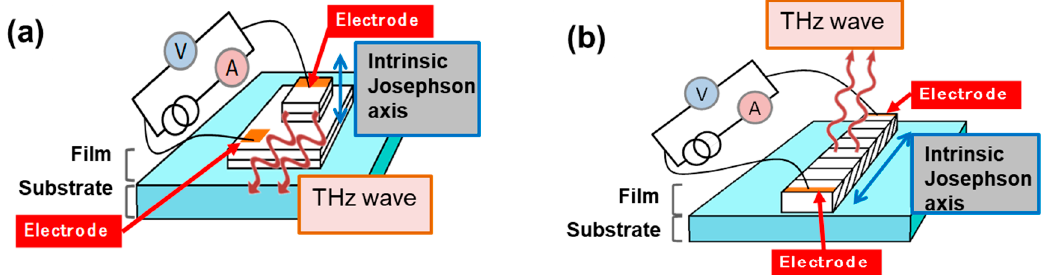
Figure 1. Schematic drawing of intrinsic Josephson junction devices for THz emission: ( a ) Mesa-type using c -axis high temperature superconductors (HTS) oriented film; ( b ) Planar-type using non c -axis HTS oriented film.